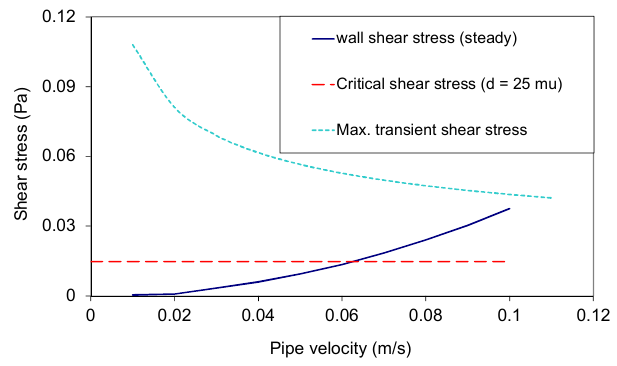
Figure 3: Wall shear stress (eq. (4) and (5)), critical shear stress for resuspension (eq. (3)) and maximum 2 Figure 3. Wall shear stress (Eqs. 4 and 5), critical shear stress for resuspension (Eq. 3) and maximum unsteady shear stress (Eq. 6).